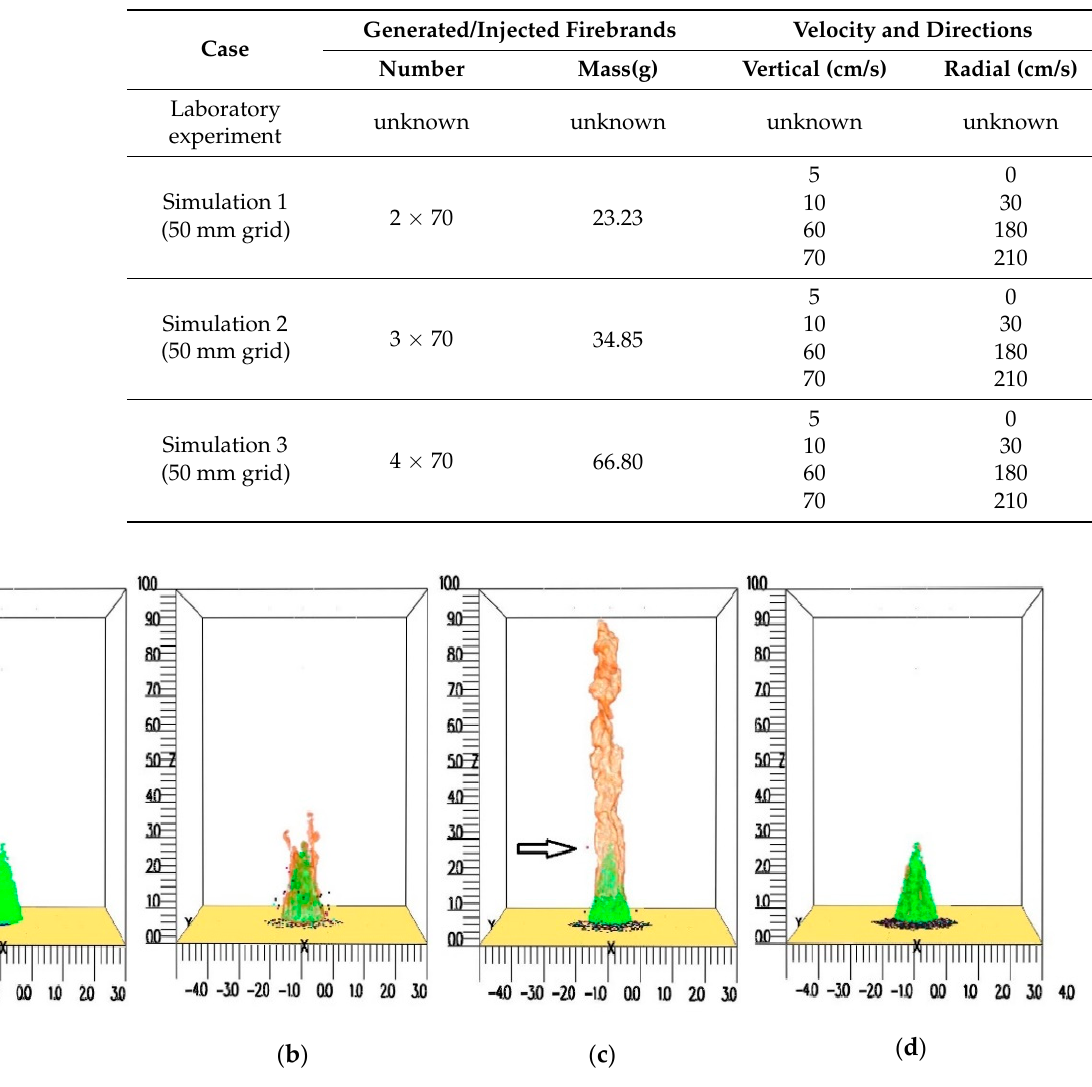
Table 5. Number, velocity, and direction of firebrand variations to obtain matching collection.